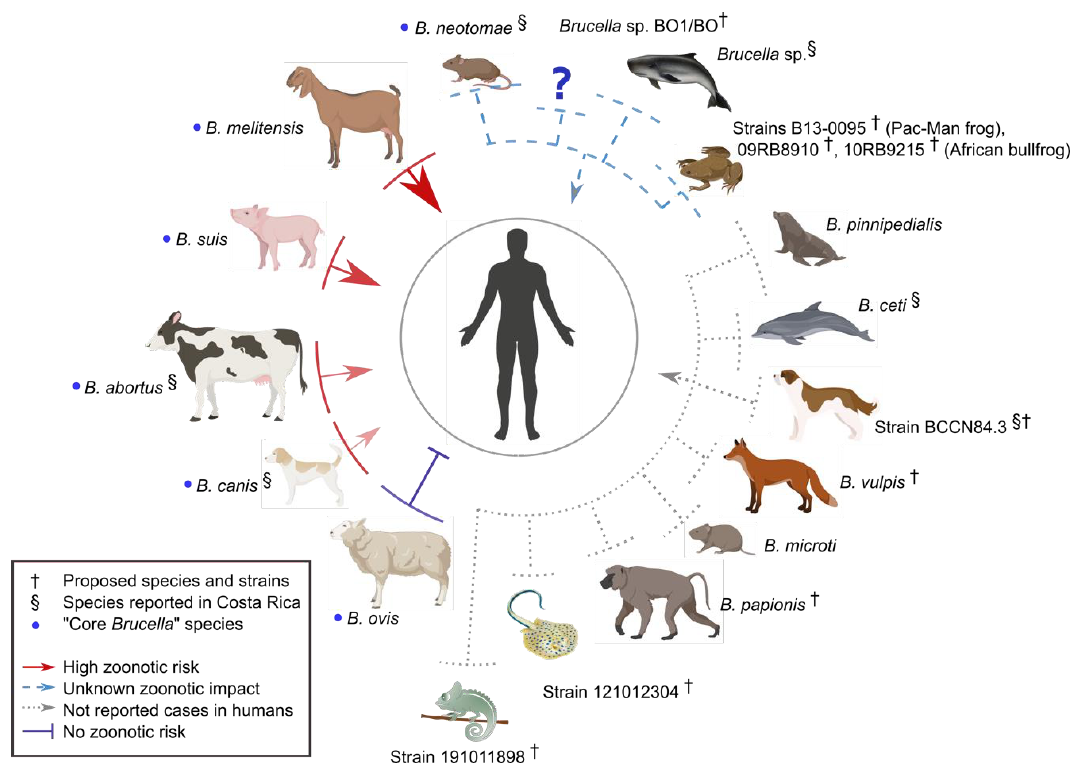
Figure 3. Zoonotic potential of the various Brucella species. The colors and arrow sizes represent the zoonotic risk displayed by each species isolated from its preferred host. Table S2 presents a detailed analysis. Created with Biorender.com.